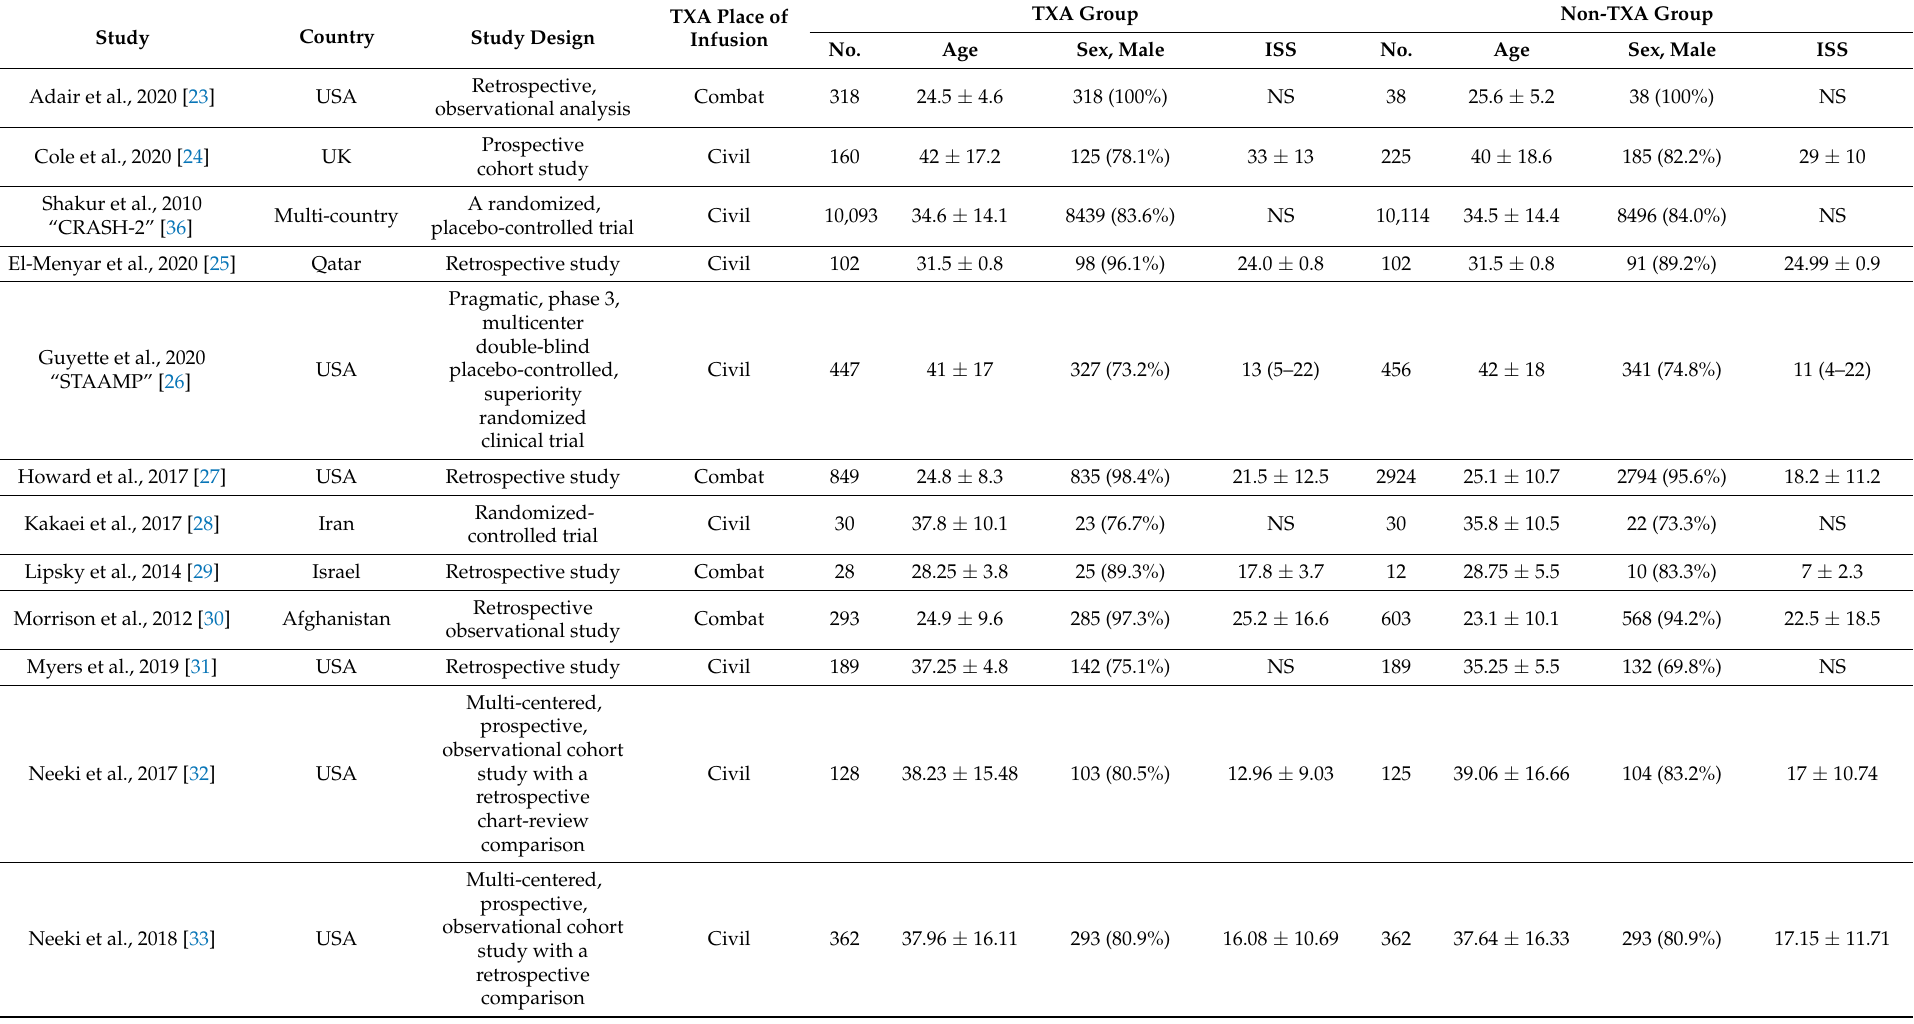
Table 1. Patient characteristics of the sixteen included